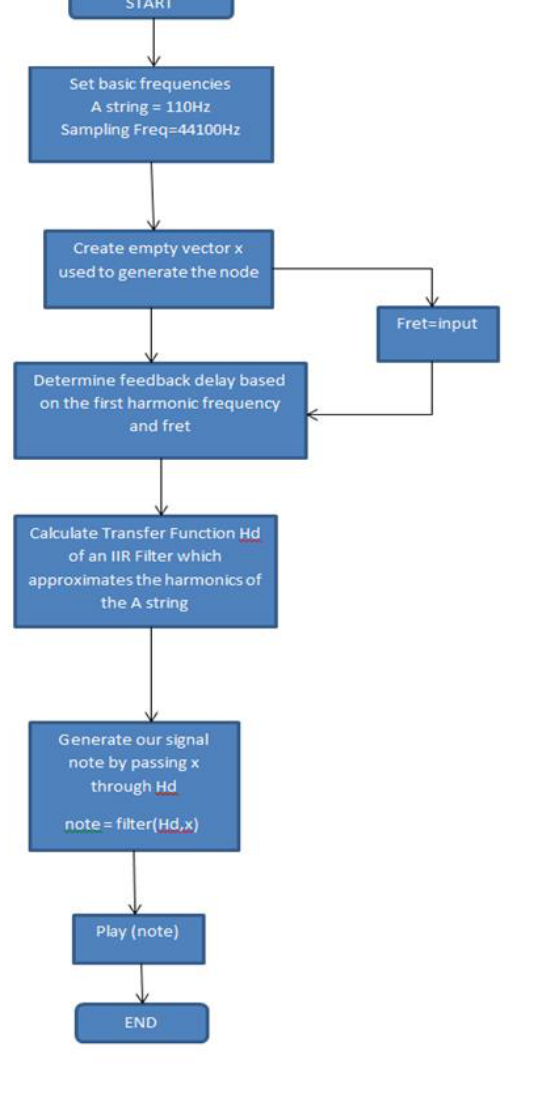
Figure 3 . Project Flowchart – Sound Module